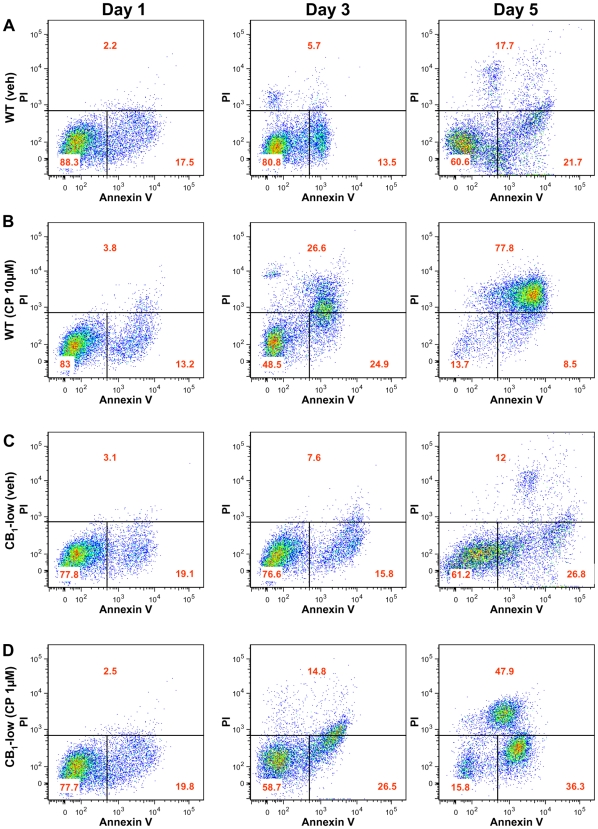
Time course of the apoptotic response induced by CP-55,940 in wild-type and CB1-low DBT cells.
(a,b) Wild-type (wt) DBT cells and (c,d) CB1-low DBT cells were expanded in 6-well plates, incubated with CP-55,940 (CP) at 10 and 1 µM, respectively, and apoptosis assessed by quantifying propidium iodine (PI) and annexin V fluorescence by FACS after 1, 3, and 5 days. Shown are representative results, with values within each quadrant = mean of 3–5 independent experiments.